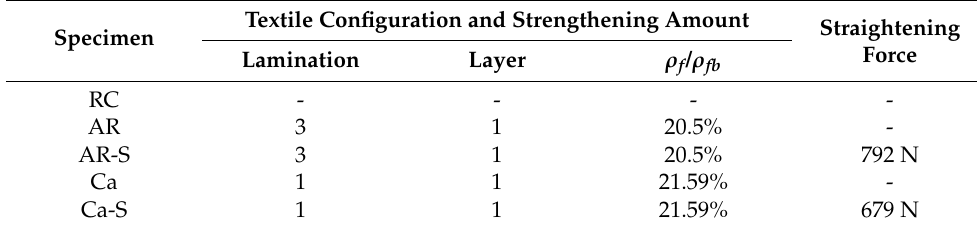
Table 2. The detailed specification of the study